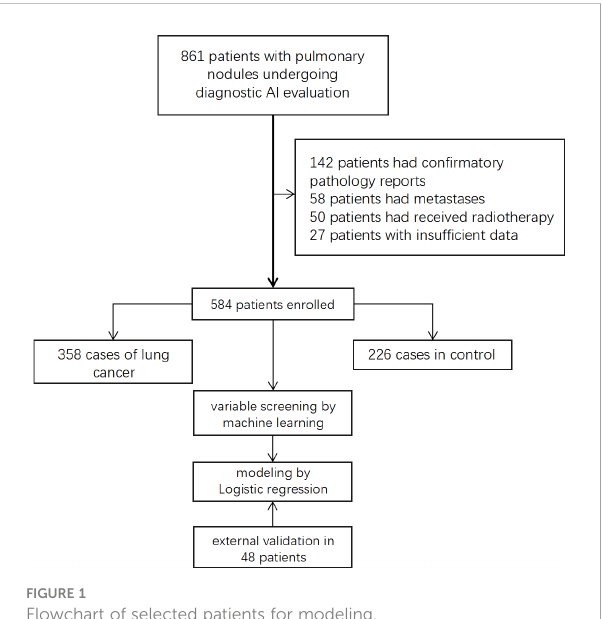
FIGURE 1 Flowchart of selected patients for modeling.